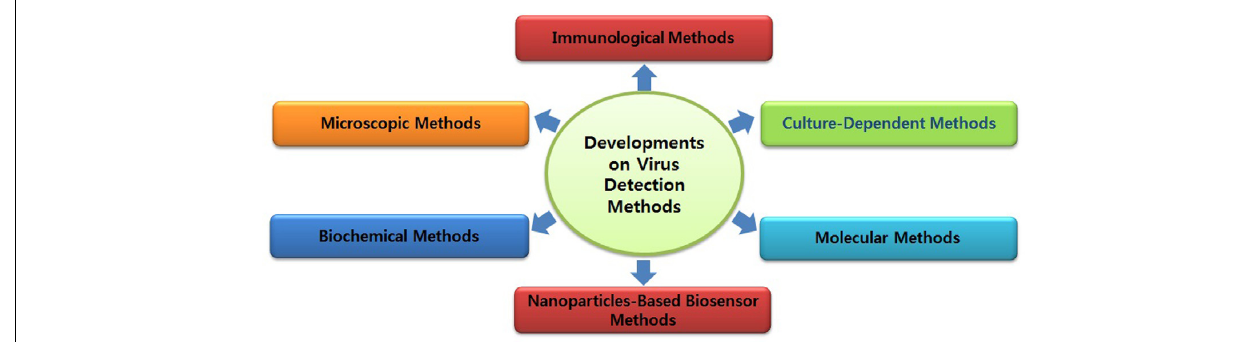
FIGURE 1 | Developments in various pathogen detection strategies.